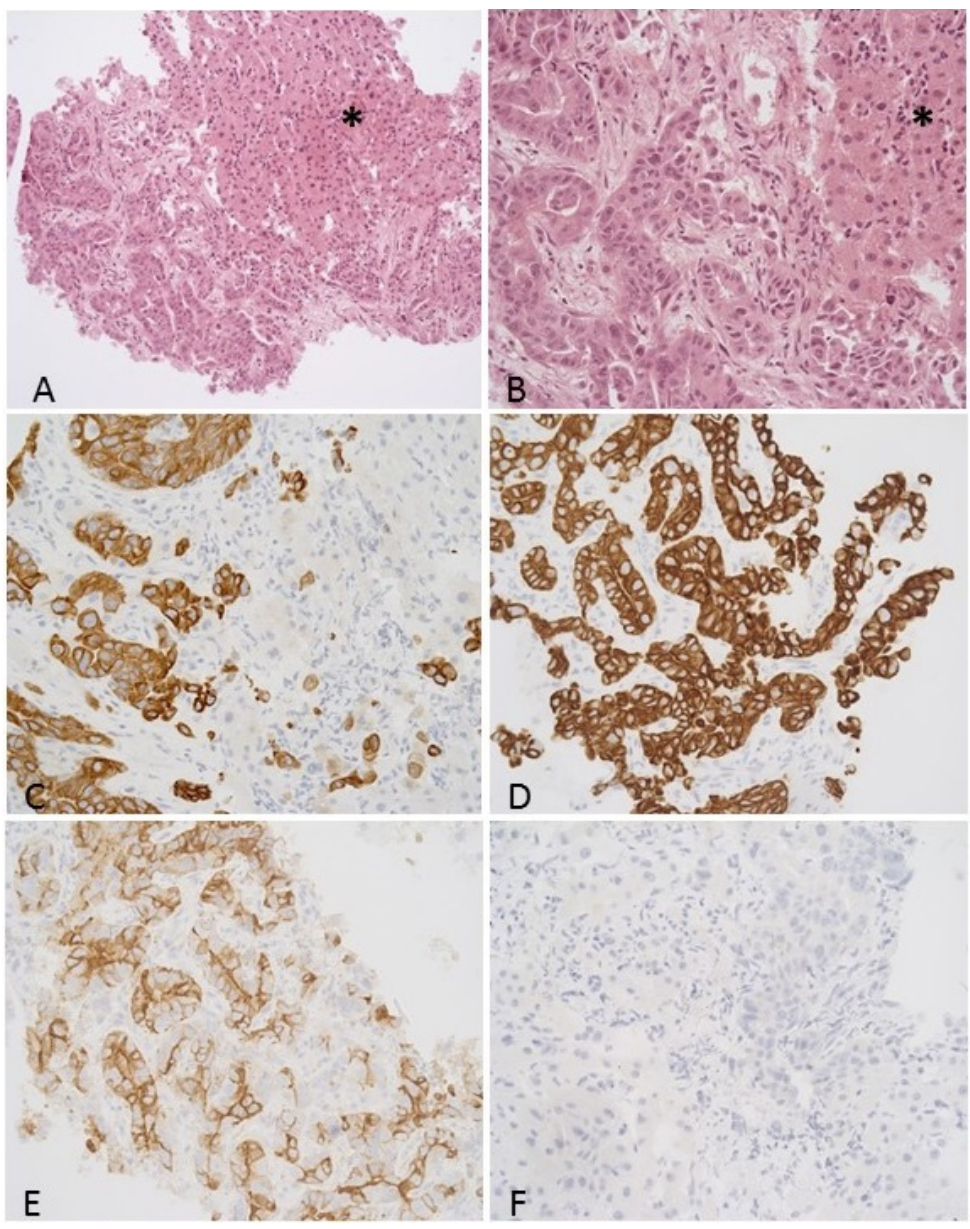
Figure 1. Representative histological and immunostaining of intrahepatic cholangiocarcinoma. ( A , B ): Core biopsy of a hepatic lesion which was consistent with intrahepatic cholangiocarcinoma (H&E, 200× and 400× magnification, respectively). The tumor is made up of irregular, atypical glandules with infiltrative growth. The neoplastic glandules are surrounded by desmoplastic stroma. Non-neoplastic hepatocytes can be seen on the right side (*). The neoplastic cells were positive for CK7 ( C ), CK19 ( D ), and Ca19-9 ( E ), while negative for CK20 ( F ) immunostaining (400× magnification).